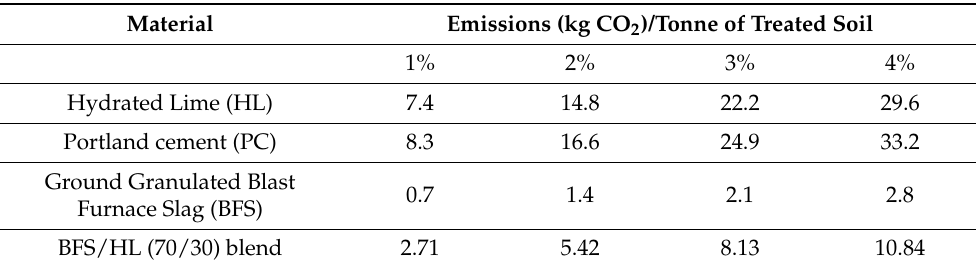
Table 6. Embodied emissions of stabilisers considered in the study for treatment levels